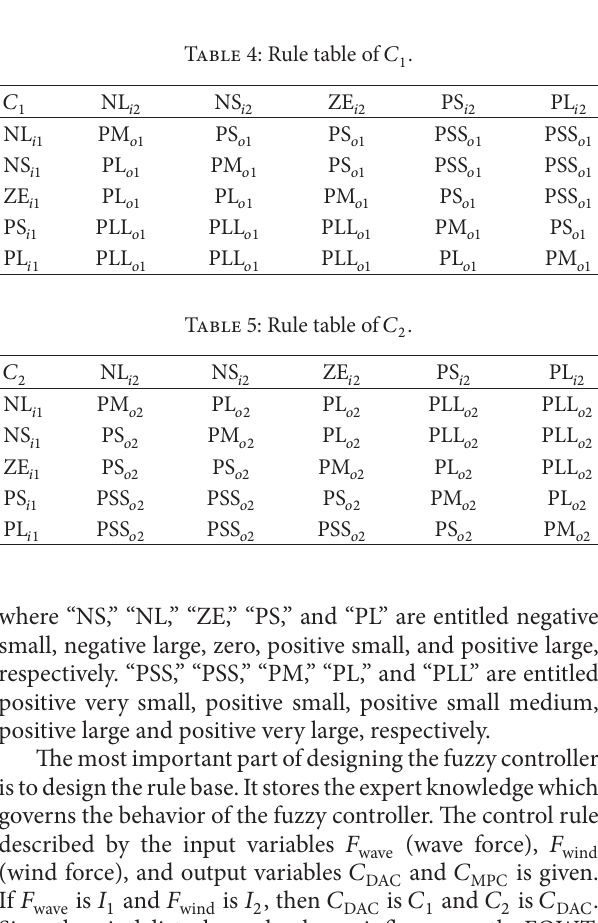
Figure 6: Pitch angles of three blades.